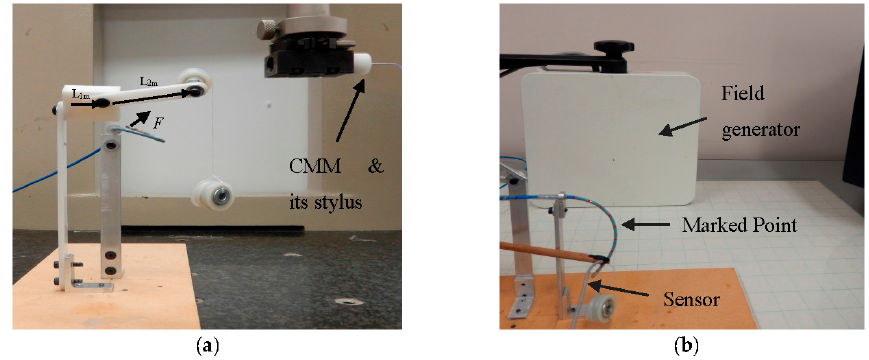
Figure 8. Experimental setup: ( a ) Loading mechanism with two moving links ( L 1m and L 2m ), pulley and weights; ( b ) Measurement system.